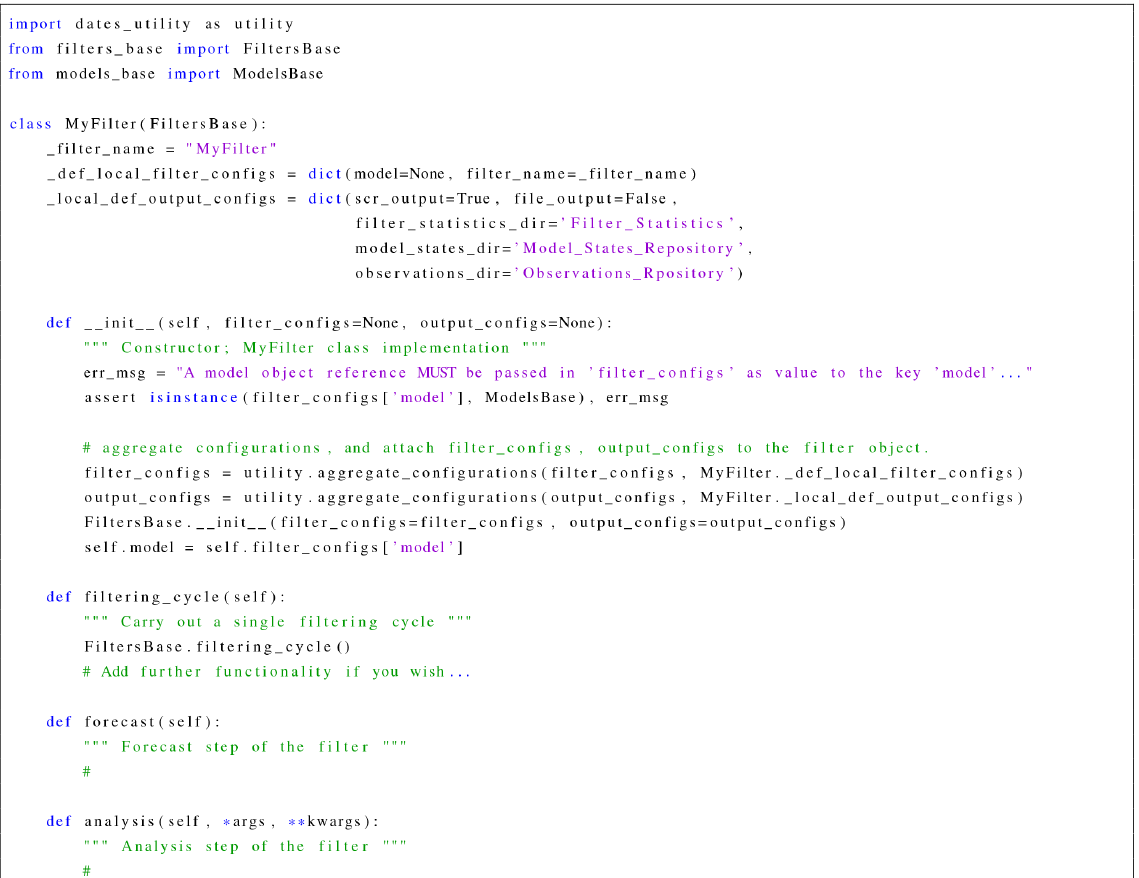
Figure 20. The leading lines of an implementation of a DA filter; the MyFilter class is derived from the filters’ base class FiltersBase